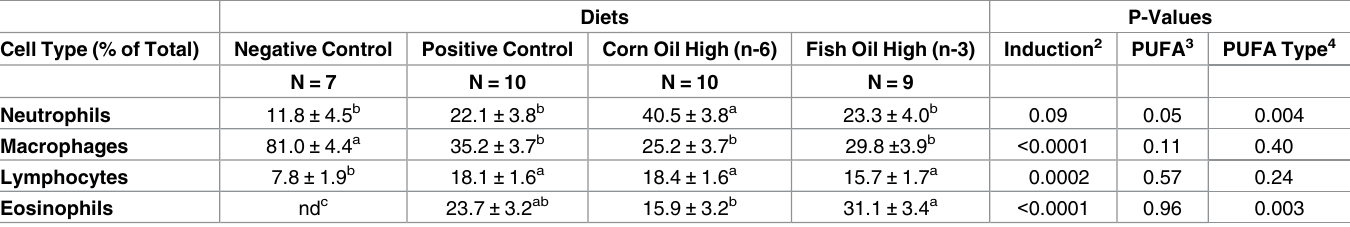
Table 4. BAL fluid cytology proportions for mice fed (n-3) or (n-6) PUFA enriched foods for 8 weeks and then sensitized and challenged with OVA for an additional 4 weeks compared with mice fed control food that were sensitized and challenged with saline (Negative Control) or OVA (Positive Control) 1